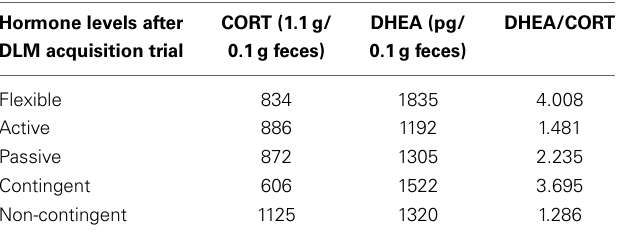
Table 3 | Corticosterone, DHEA, and DHEA/Corticosterone ratios by coping and training.